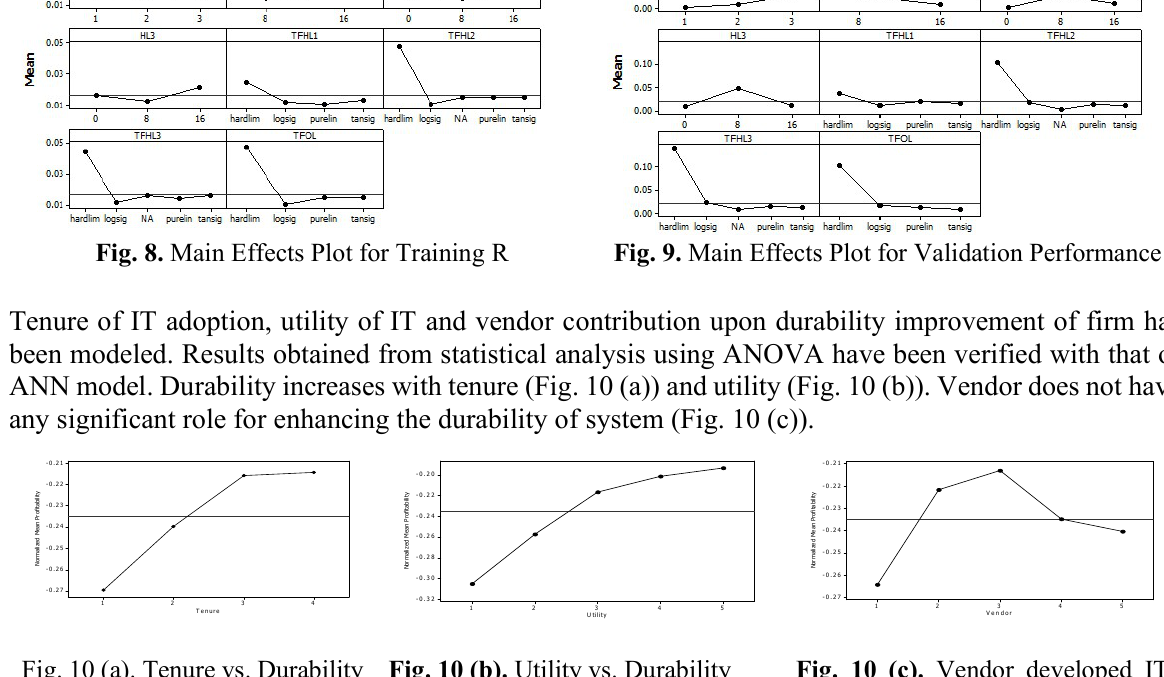
Fig. 10 (a). Tenure vs. Durability Fig. 10 (b). Utility vs. Durability Fig. 10 (c). Vendor developed IT